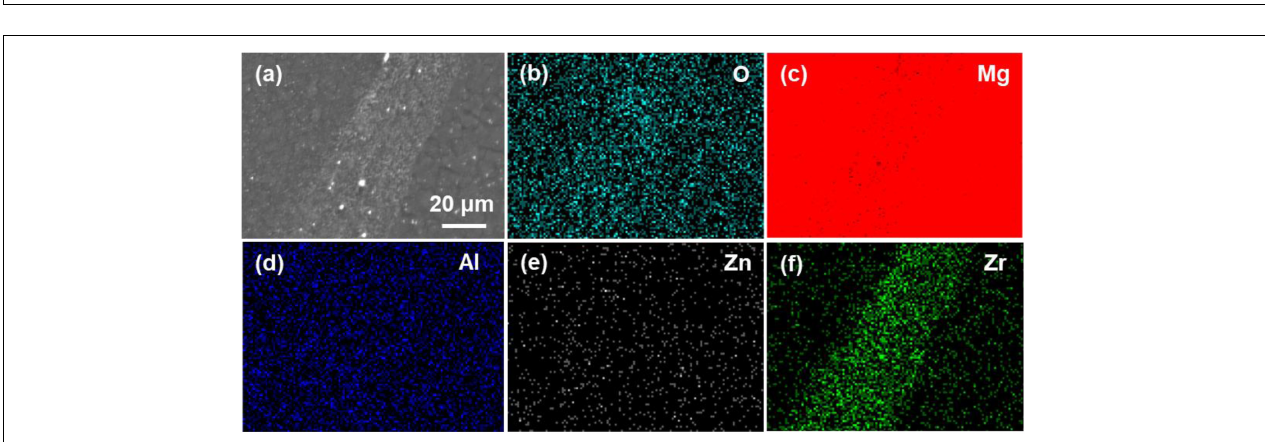
FIGURE 2 | SEM-EDS mapping shows (a) the ZrO 2 particles embedded in matrix (b–f) color mapping of elements O, Mg, Al, Zn, and Zr of the SZ-center in FSPed AZ31/ZrO 2 composite (Z3-1P specimen).